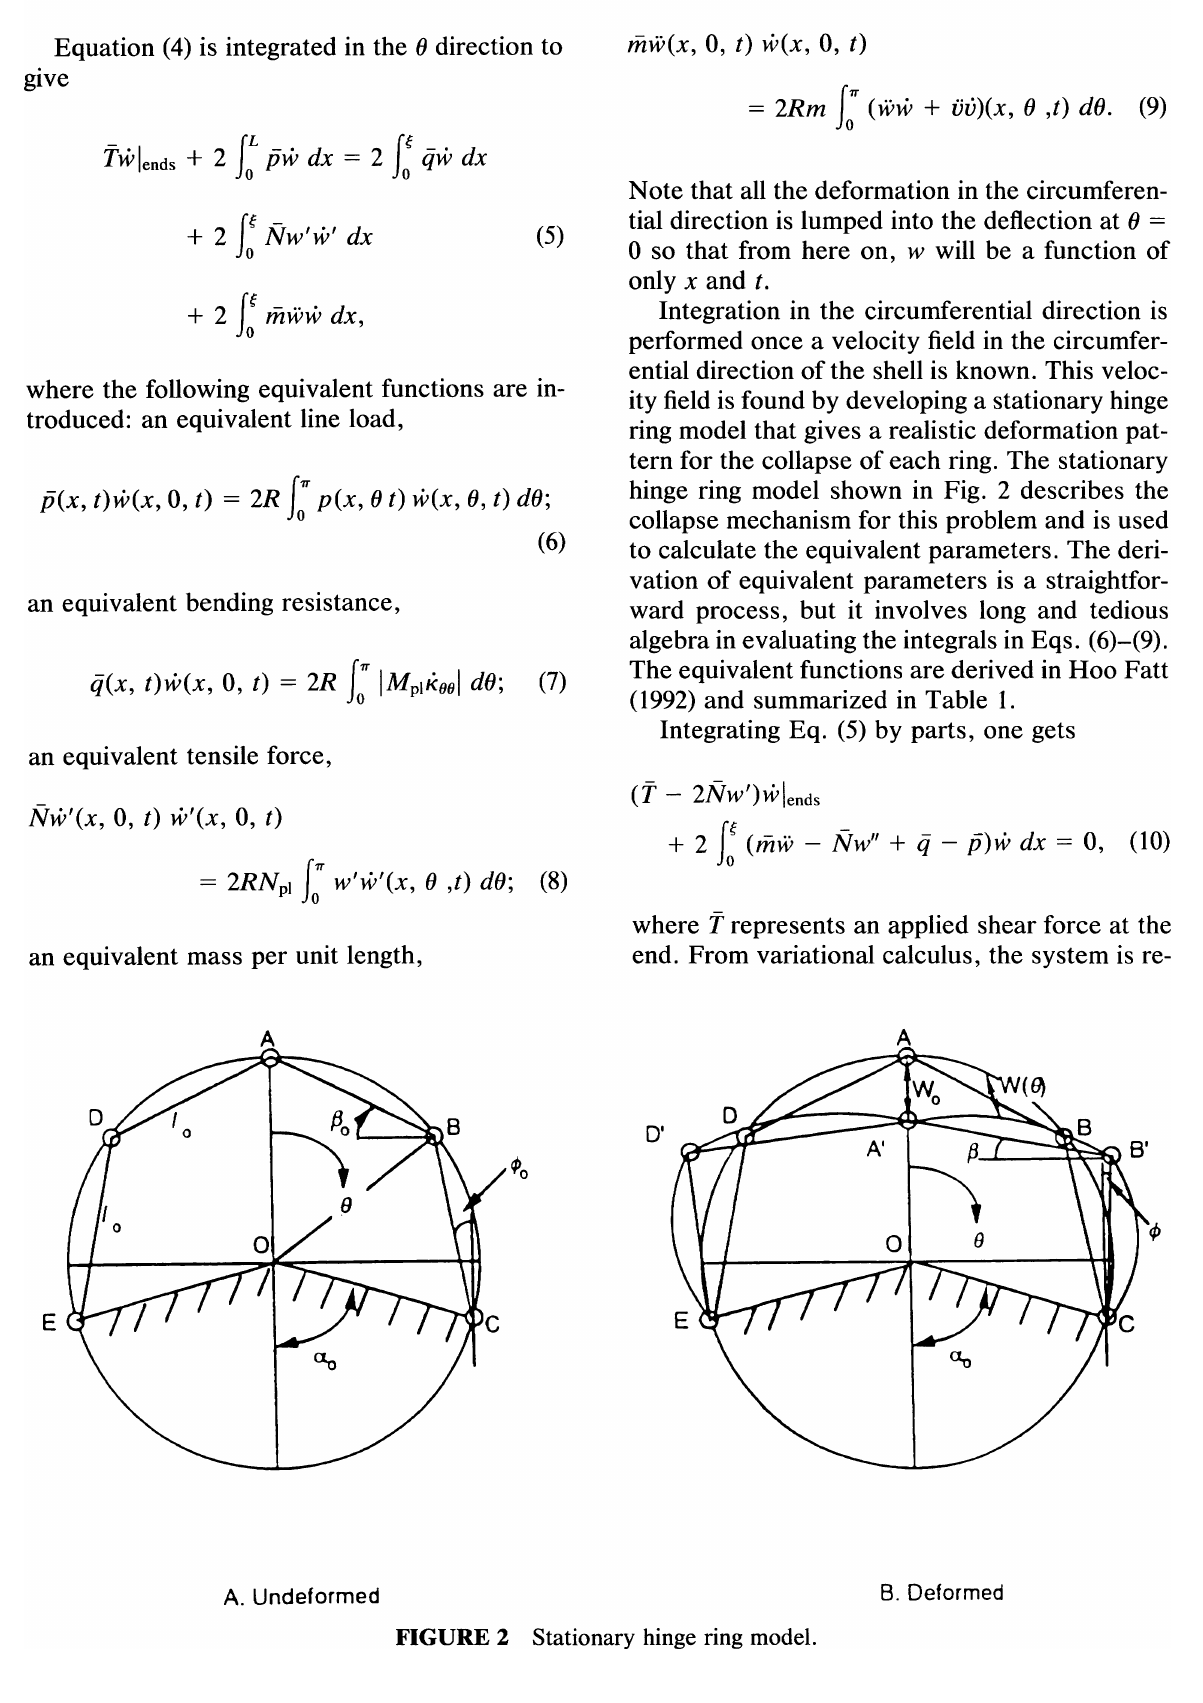
FIGURE 2 Stationary hinge ring